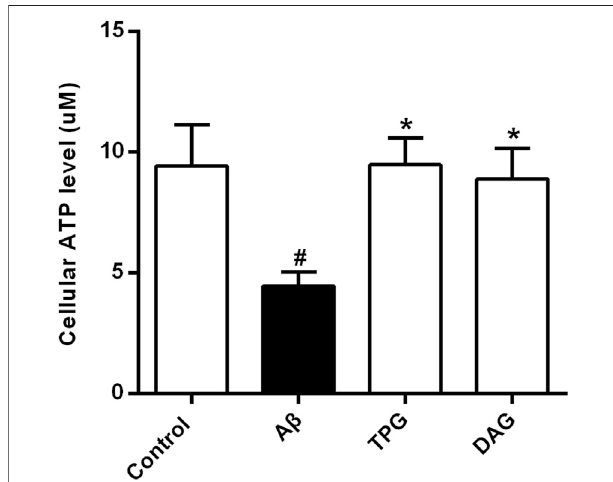
FIGURE 3 | The improvement of TPG and DAG on the intracellular ATP level in A β 25 – 35 -exposed cells. The concentrations of intracellular ATP level in different groups. All values were shown as mean ± SEM from three independentstudies.Statisticalanalyseswereperformedusingone-way ANOVA and Tukey-HSD post hoc comparisons. # p < 0.05, vs. control group; * p ＜ 0.05,vs. A β 25 – 35 models. TPG, tortoise plastron gelatin; DAG, deer antler gelatin.